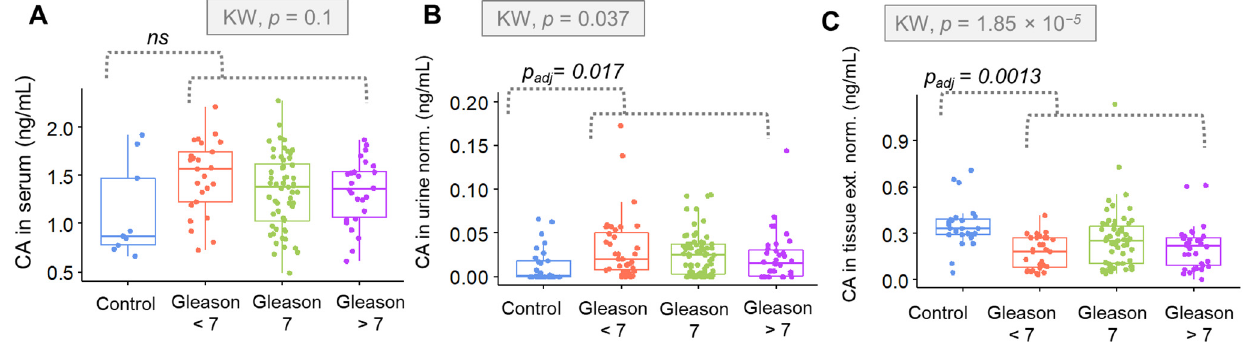
Figure 6. Box plots showing the comparison between the means of citric acid levels determined in ( A ) serum samples; ( B ) urine samples and ( C ) tissue extracts, according to the cancer clinical staging. CA = citric acid, KW = Kruskal–Wallis test, p adj = adjusted p ‐ value according to the B ‐ H method for the referred comparison, as reported by the Mann–Whitney test, ns = non ‐ significant, norm. = normalized to creatinine (in the case of urine) or to weight (in the case of tissue) and ext. = extract.